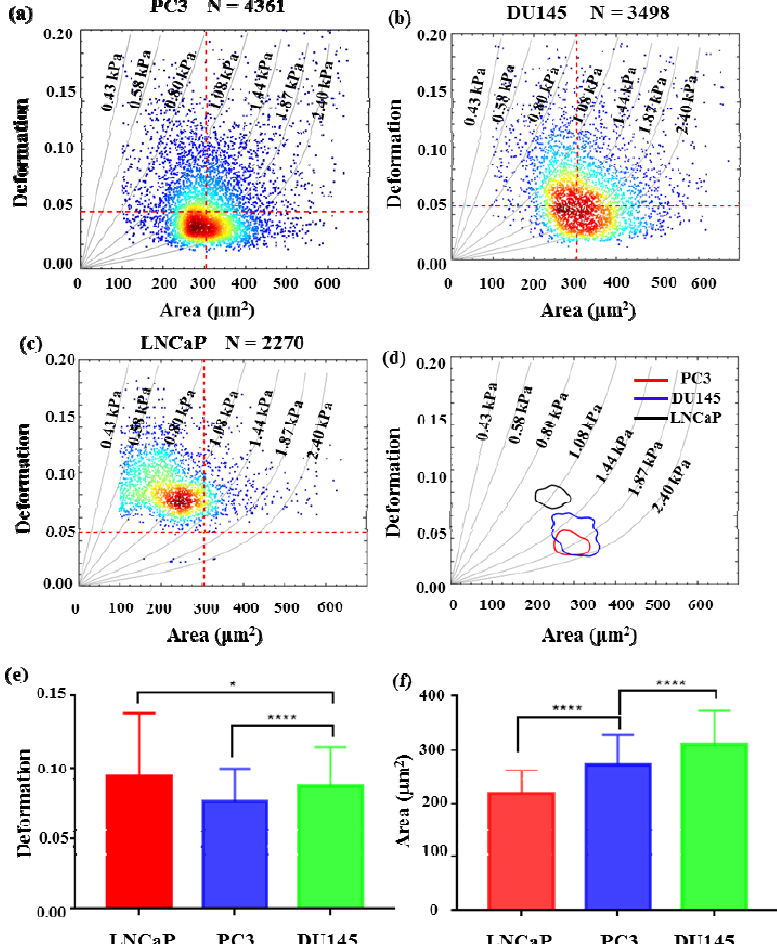
Figure 6. The mechanical phenotyping of prostate cancer cell lines. The scatter plot of cell deformation versus cell area ( a ) PC3, ( b ) DU145, ( c ) LNCaP. Each dot represents the information of a single cell. ( d ) The 50% density contour line of three types of prostate cancer cell lines. ( e ) The averaged deformation degree of three types of prostate cancer cell lines. ( f ) The averaged area of three types of prostate cancer cell lines. (* indicates a p value of less than 0.05, **** indicates a p value of less than 0.0001).